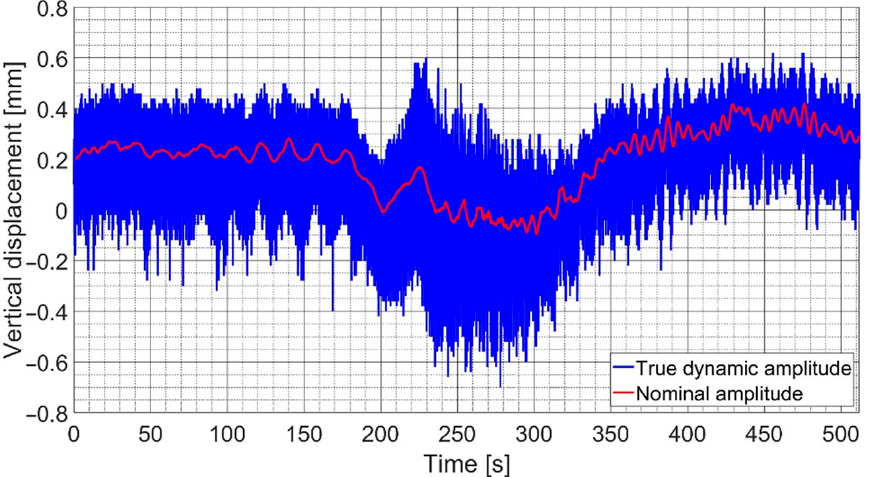
Figure 9. True dynamic bending moment in the vertical direction during rapid port turn.